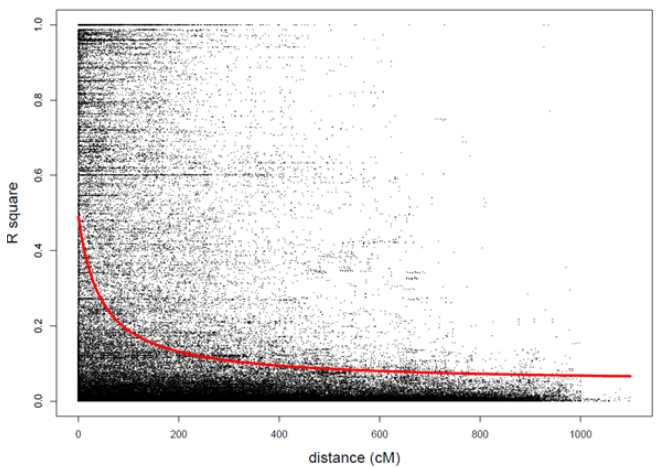
Figure 2. Decay of the linkage disequilibrium (LD) ( r 2 ) is presented for the 2785 markers used in the analysis. The figure presents r 2 LD for each marker pair within chromosomes plotted against their distance (cM). The red line is the nonlinear regression line based on Hill and Weir [101]. Agronomy 2019 , 9 , x FOR PEER REVIEW 11 of 22